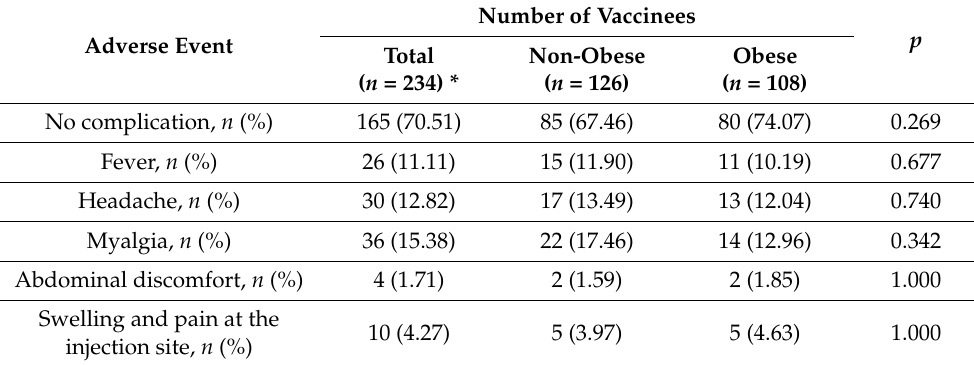
Table 4. List of adverse events observed within 72 h